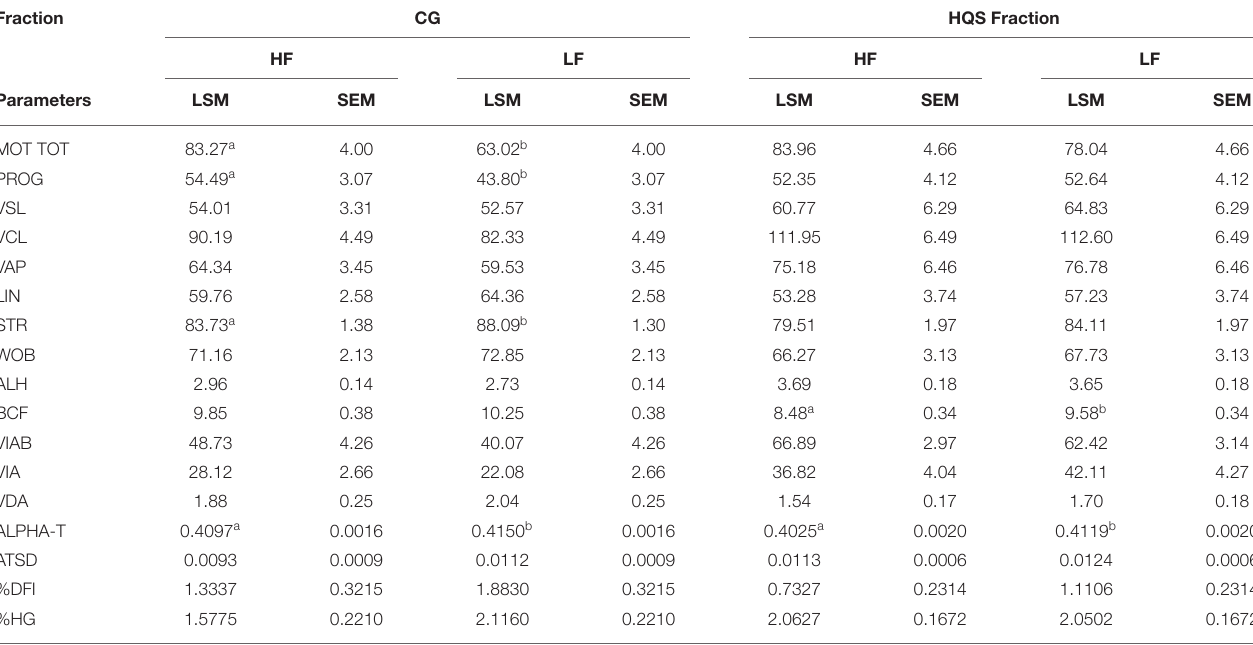
TABLE 3 | In vitro sperm quality parameters assessed on frozen-thawed semen doses by CASA and FCM of 10 Holstein bulls based on fertility ranking in the CG and HQS fraction (LSM ± SEM). Fraction CG